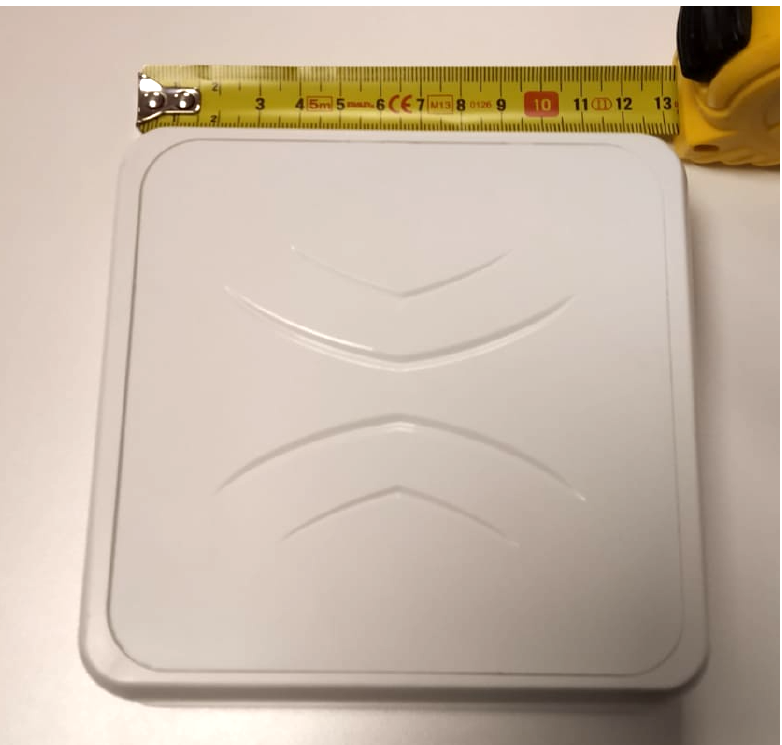
Figure 11. Receiver